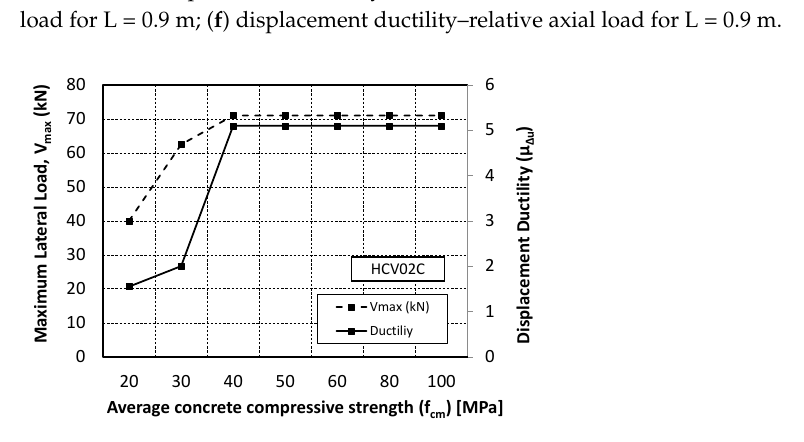
Figure 11. Maximum load and displacement ductility in the specimens made of two concrete types and steel reinforcements. Continuous joint (Phase 2): ( a ) lateral load–relative axial load for L = 0.3 m; ( b ) displacement ductility–relative axial load for L = 0.3 m; ( c ) lateral load–relative axial load for L = 0.6 m; ( d ) displacement ductility–relative axial load for L = 0.6 m; ( e ) lateral load–relative axial load for L = 0.9 m; ( f ) displacement ductility–relative axial load for L = 0.9 m.